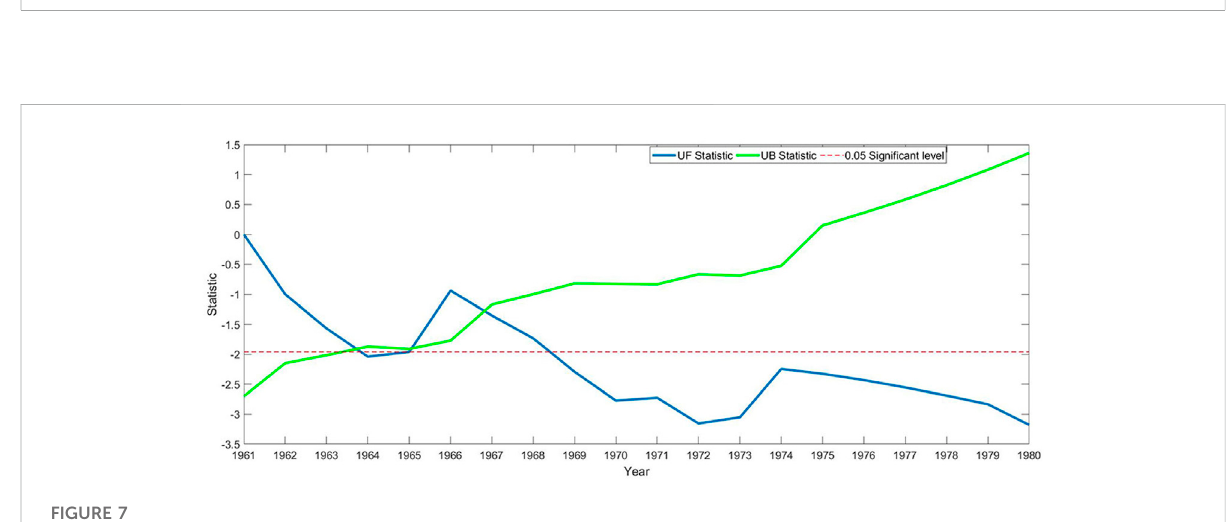
FIGURE 7 Hydrological drought month number mutation